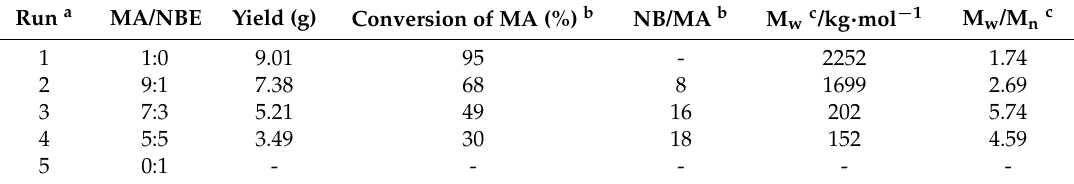
Table 2. Copolymerization of MA and NB by complexes Pd3 a